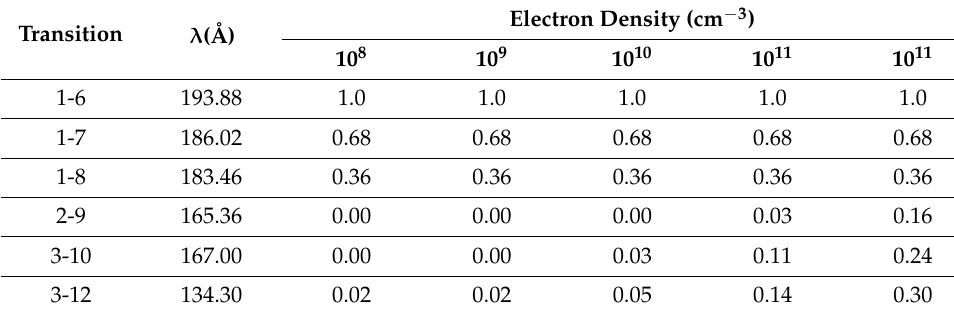
Table 4. Intensity ratios relative to transition 1-6 for N e (cm − 3 ) for Ca